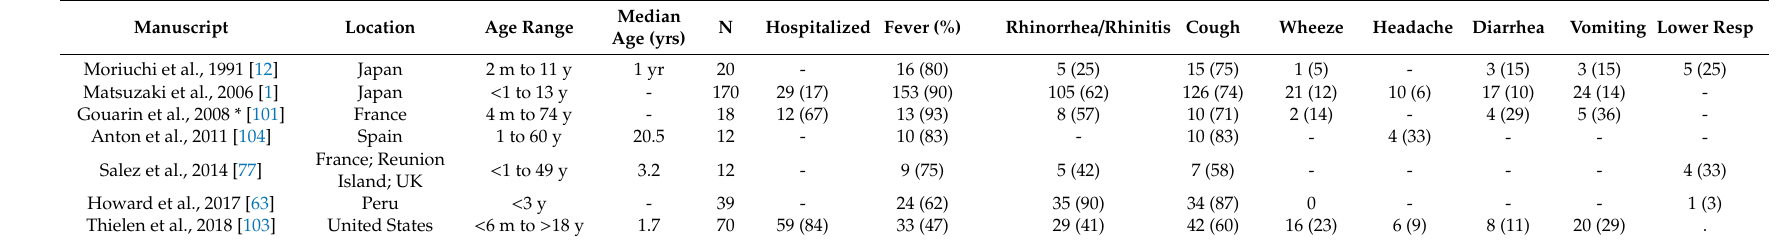
Table 1. Summary of clinical characteristics of patients infected with influenza C